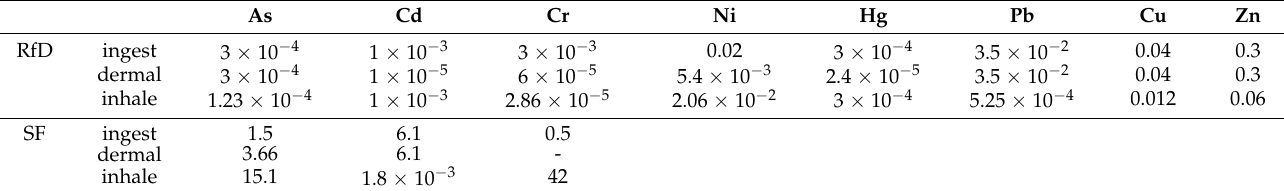
Table 3. Soil parameter values of SF and RFD.